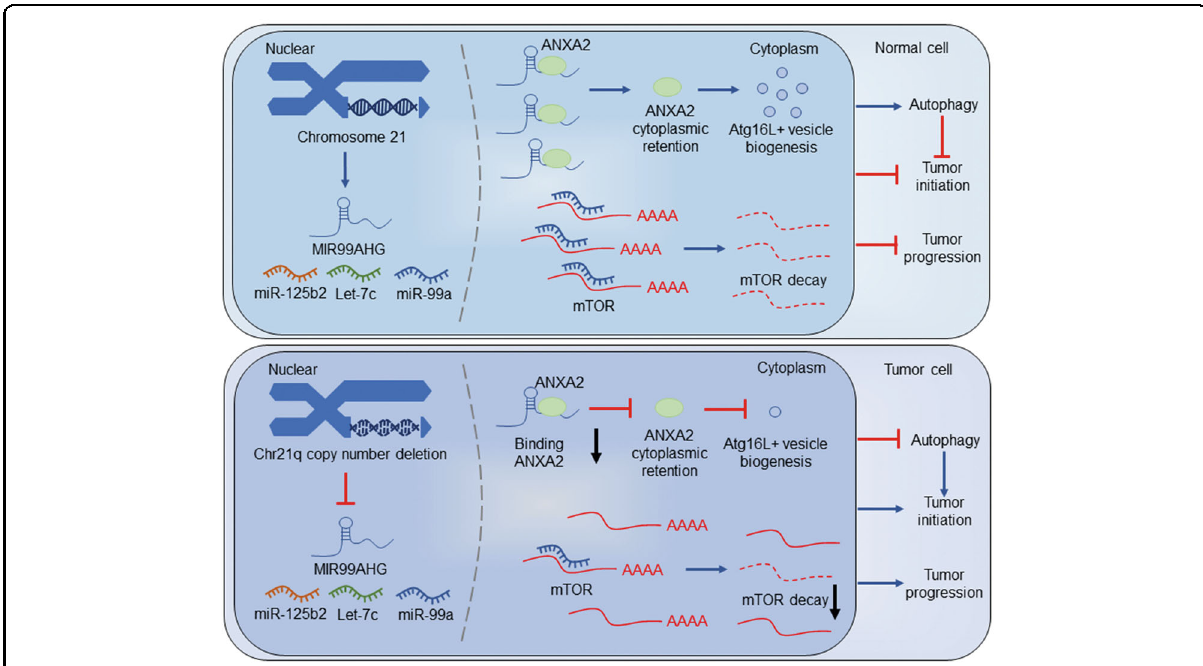
Fig. 8 Schematic diagram of how MIR99AHG promotes autophagy and inhibits the progression of LUAD. In tumor cells, copy number deletion of 21q leads to the low expression of MIR99AHG and the miR-99a/let-7c/miR-125b2 cluster. MIR99AHG binds to ANXA2 to sustain cytoplasmic retention of ANXA2 which accelerates the biogenesis of ATG16L + vesicles, and MIR99AHG-derived miR-99a targets mTOR, thus promoting autophagy and repressing the progression of LUAD. MIR99AHG/miR-99a-mediated autophagy enhanced the inhibition effect of these antitumor genes on the LUAD biogenesis, while loss of the autophagy promoted the tumor initiation induced by de fi ciency of these tumor